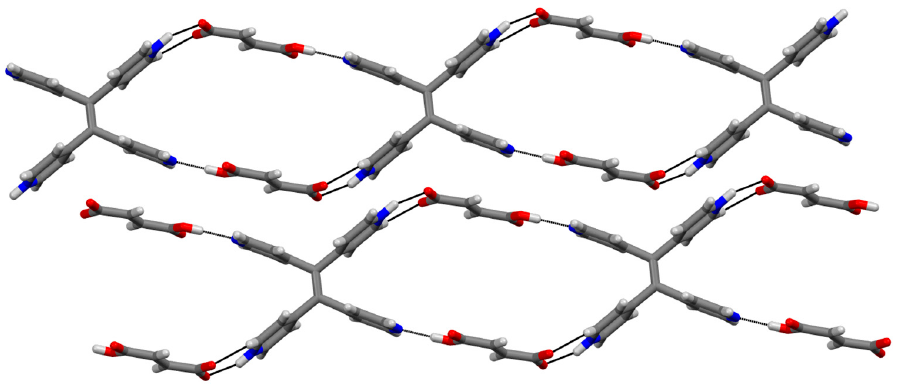
Figure 7. Charge-assisted parallel H-bonded chains of fumarate mono-anion and bis(pyridyl)-bis(pyridinium)ethylene.